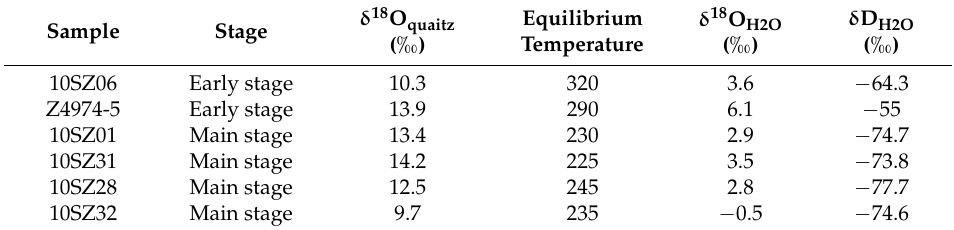
Table 3. The H–O isotope composition of the Sizhuang gold deposit. Sample Stage